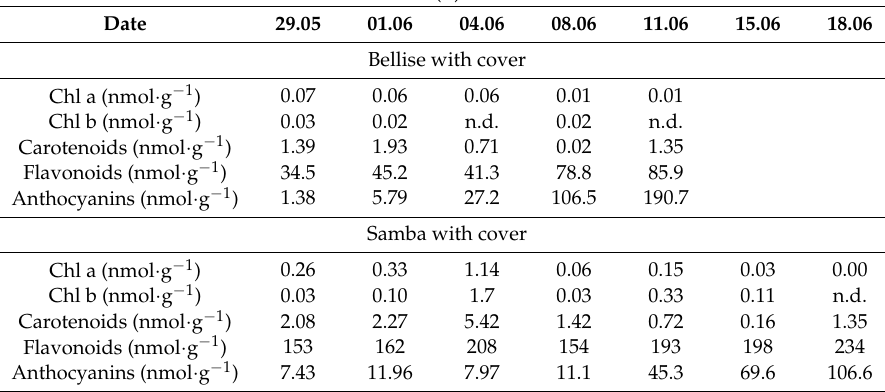
Table 2. ( a ) Pigment content during fruit maturation of sweet cherry cultivar “Samba” and “Bellise” with cover. All results are given in nmol per gram of fresh mass. ( n = 30; n.d. not detectable). ( b ) Pigment content during fruit maturation of sweet cherry cultivar “Samba” and “Bellise” without cover. All results are given in nmol per gram of fresh mass. ( n = 30; n.d. not detectable).